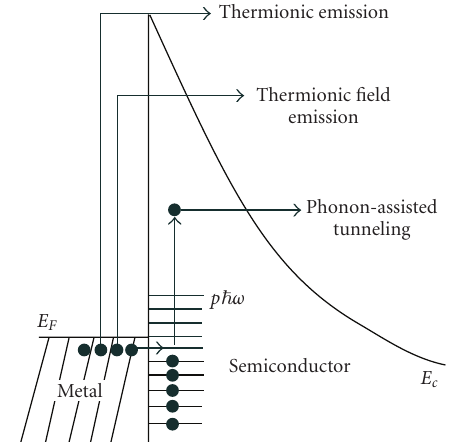
Figure 1: Energy diagram of the metal/semiconductor contact.